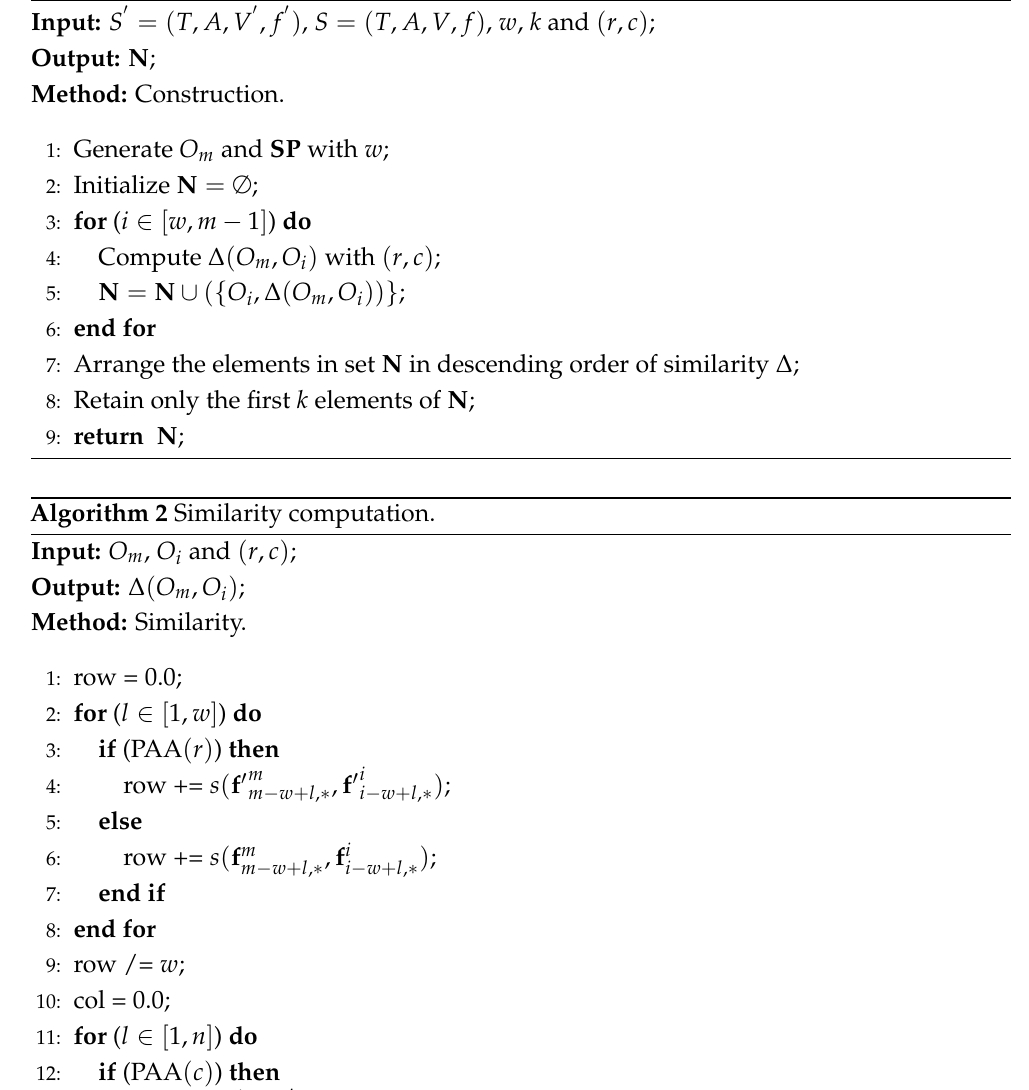
Algorithm 1 k NMN construction.